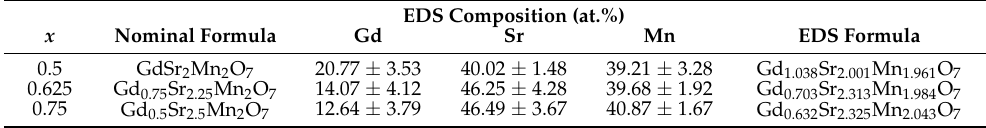
Table 2. The measured compositions from EDS results for Gd 2 − 2 x Sr 1+2 x Mn 2 O 7 ( x = 0.5, 0.625,